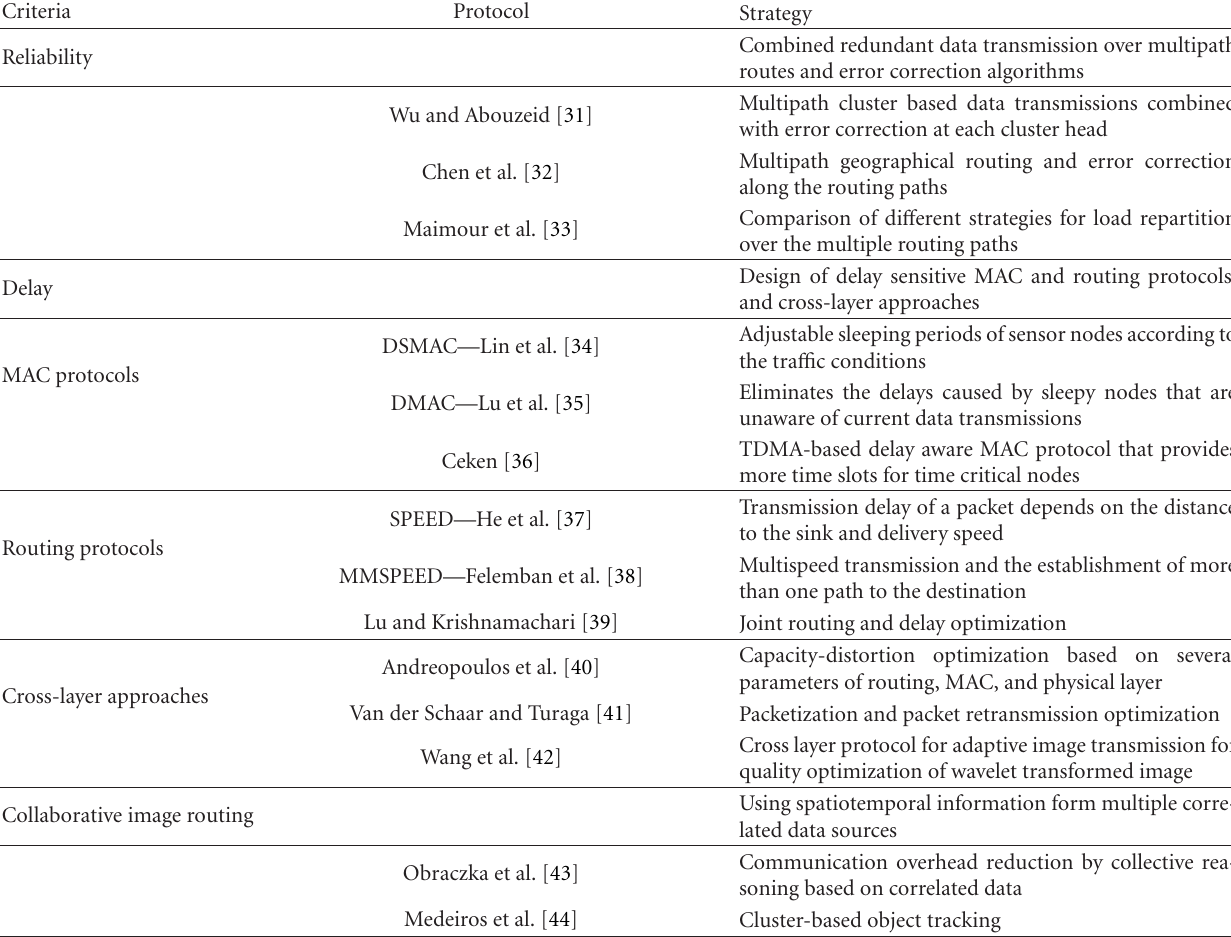
Table 2: Representatives of networking protocols used in visual sensor